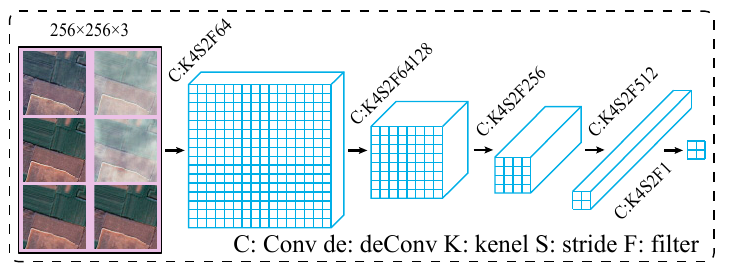
Figure 3. Structure of the discrimination network .